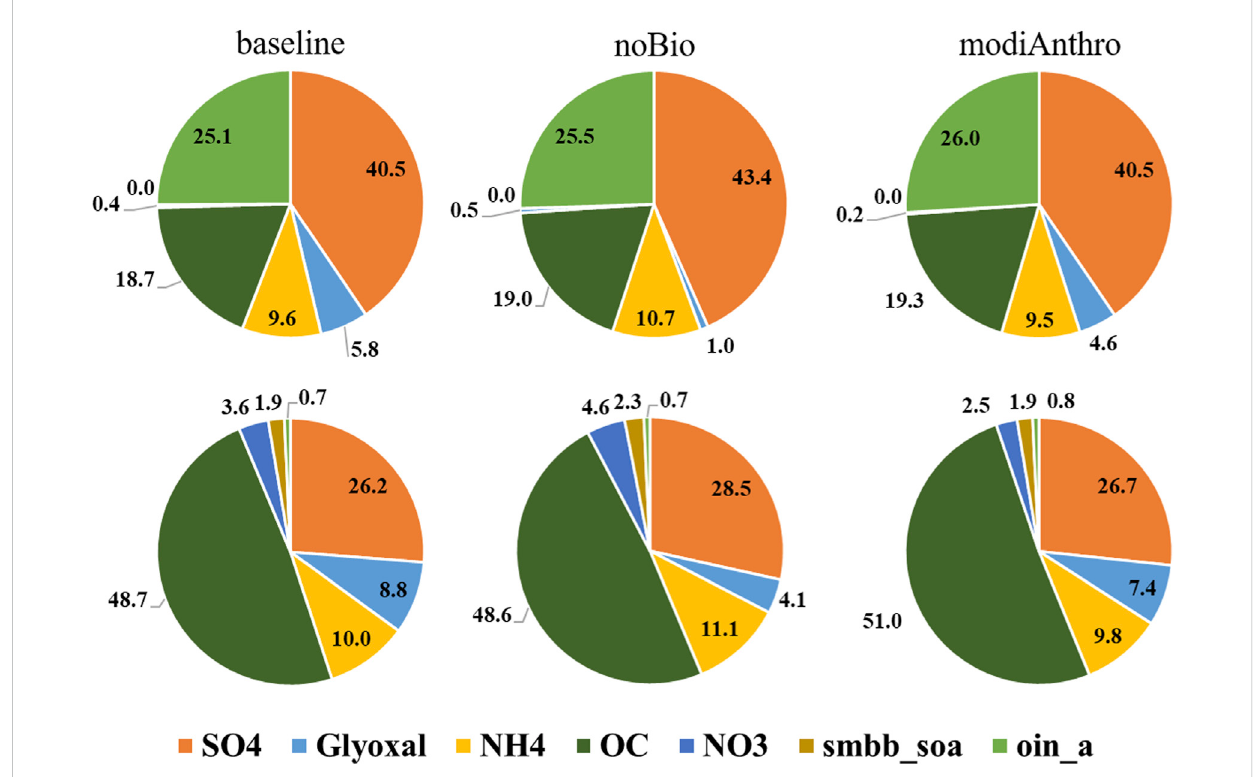
FIGURE 5 Domain wide average of PM 2.5 chemical compositions including sulfate aerosol (SO 4 ), secondary organic aerosol (SOA) from glyoxal (Glyoxal),